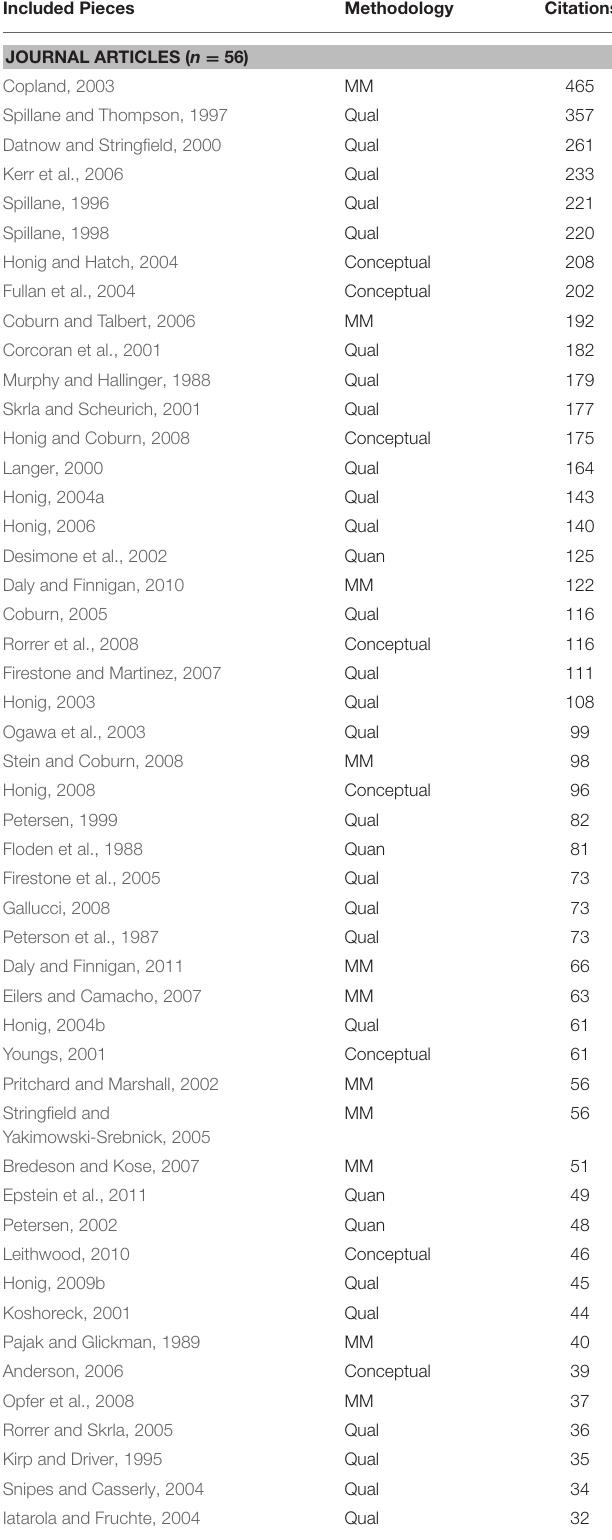
TABLE 2 | Publications with Methodology and Google Scholar